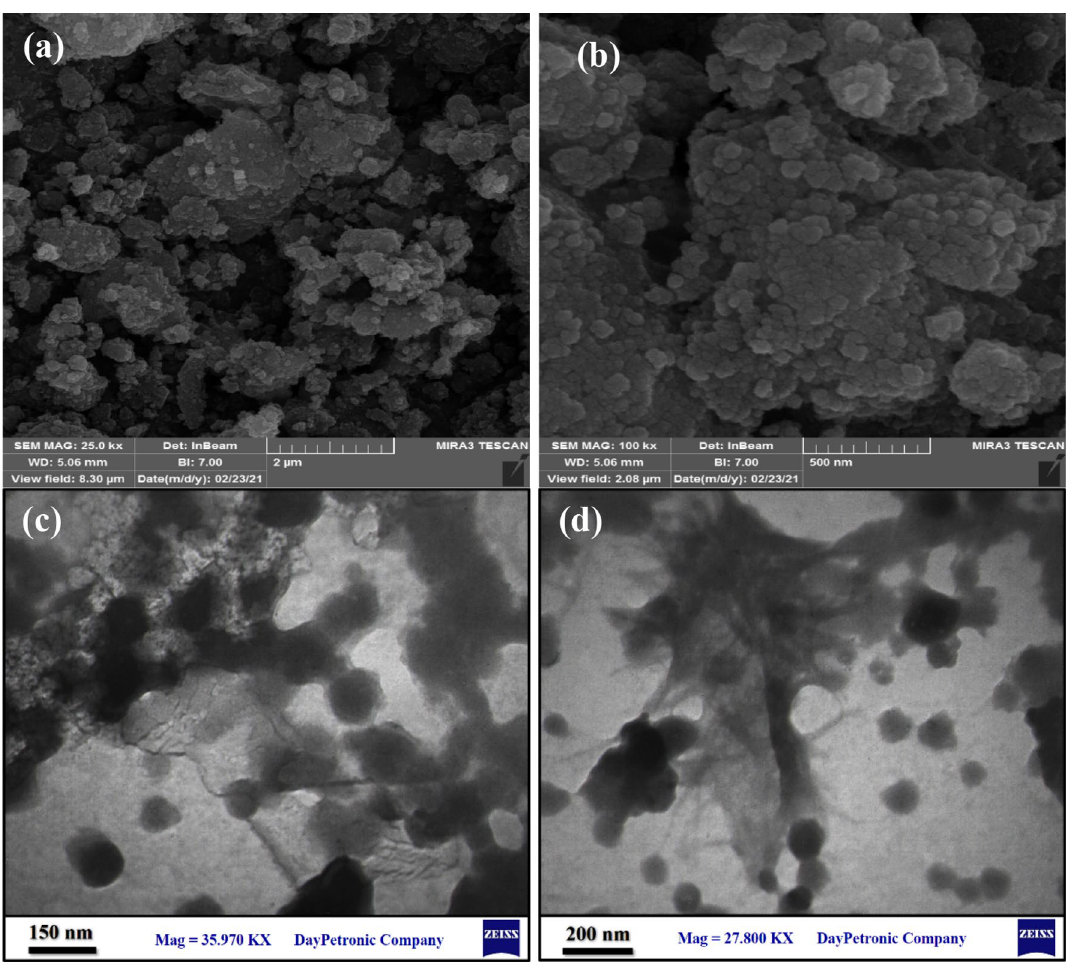
Figure 2. ( a , b ) FESEM images and ( c , d ) TEM images of the biochar/Fe 3 O 4 –Ag